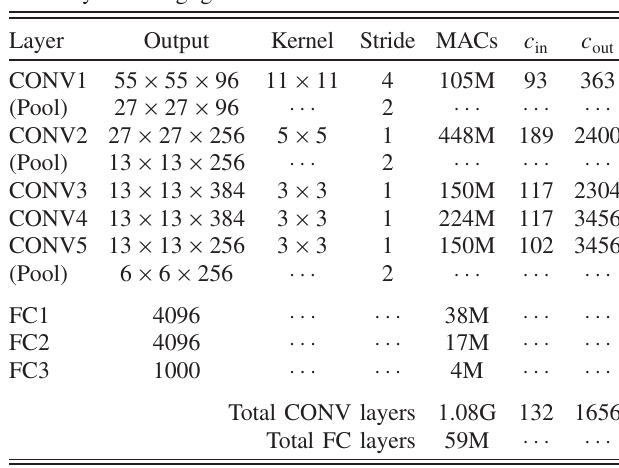
performance. TABLE I. Layers in ALEXNET [1]. Input dimension is 227 × 227 × 3 . Values of c , c are calculated from Eq. (7). in out Max pooling layers after CONV1, CONV2, and CONV5 are used to reduce the image size, but the relative computational cost for these layers is negligible.